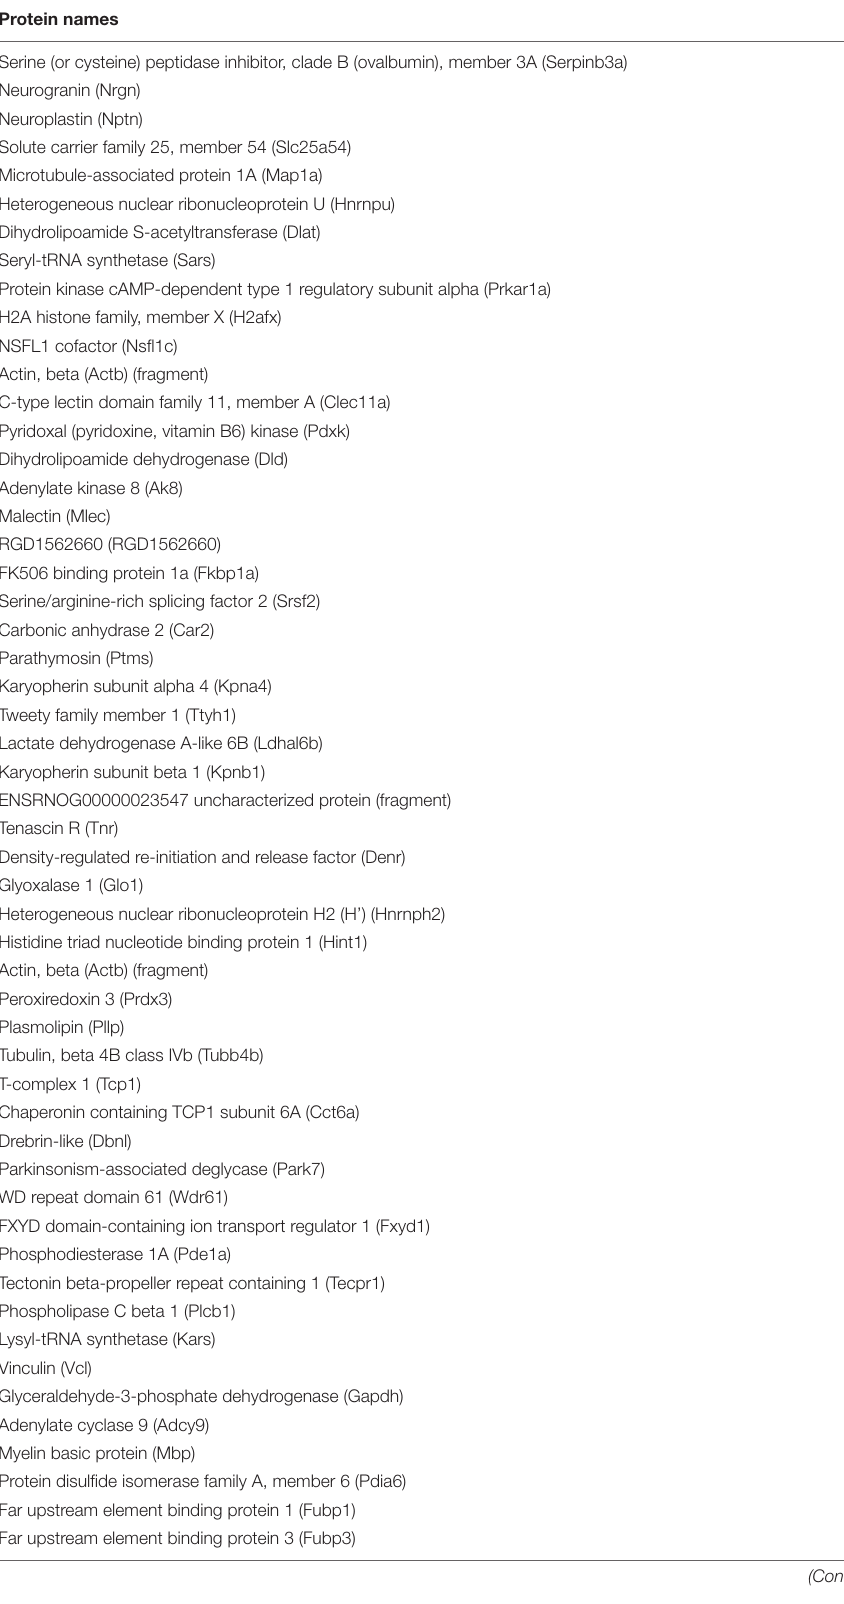
TABLE 1 | Upregulated proteins in the hippocampus of